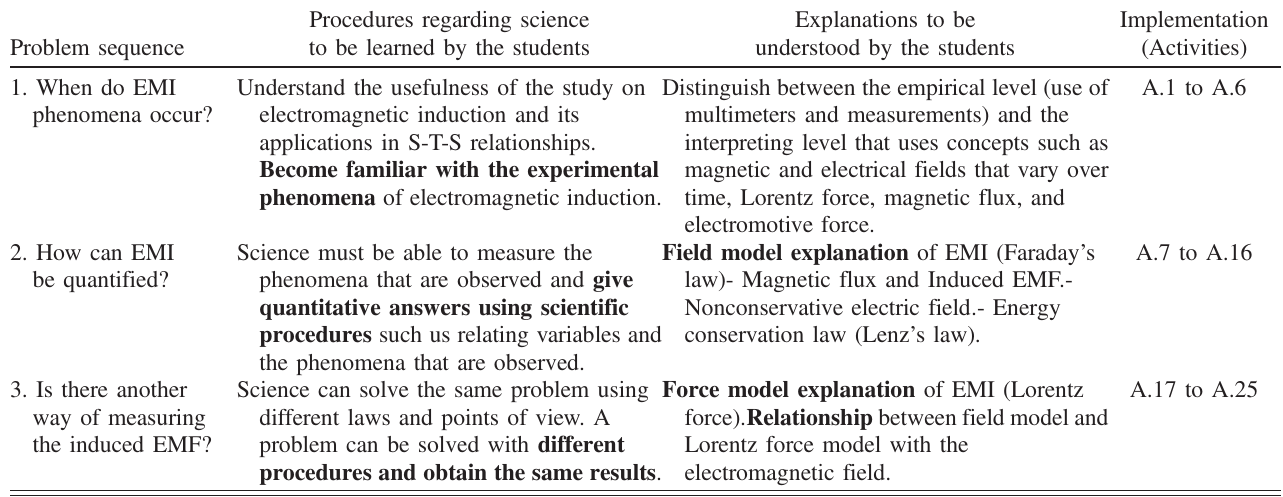
TABLE I. Teaching sequence on electromagnetic